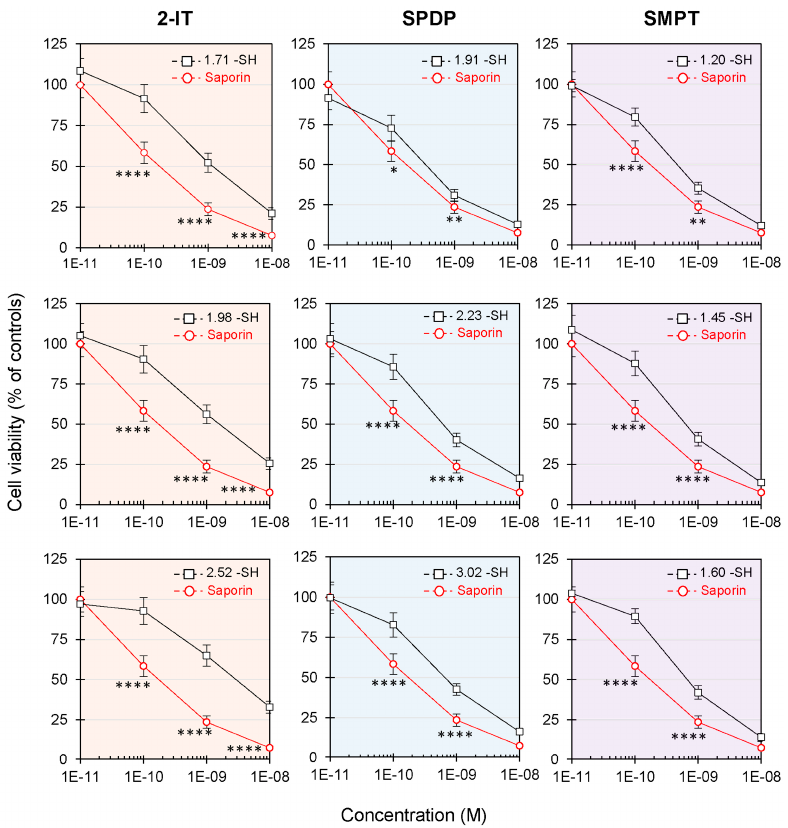
Figure 3. E ff ect of derivatized saporin on NB100 cell viability. NB100 cells were incubated for 72 h with scalar concentrations (M) of native saporin (red) and saporin derivatized with 2-IT, SPDP or SMPT (black). Cell viability was measured by MTS salt reduction, as described in Materials and Methods, and was expressed as percentage of untreated cells (% of controls). The e ff ective concentration in reducing by 50% viability of NB100 cells (EC 50 ) was calculated by linear regression analysis. This statistical approach was used to analyze the dose-response experiments in the linear range of the curves. Results are expressed as means ± SD of three di ff erent experiments, each conducted in quadruplicate. SD never exceeds 10%. Data were analyzed by ANOVA test (con fi dence range 95%; * p < 0.05, ** p < 0.01, **** p < 0.0001 derivatized saporin versus native saporin).